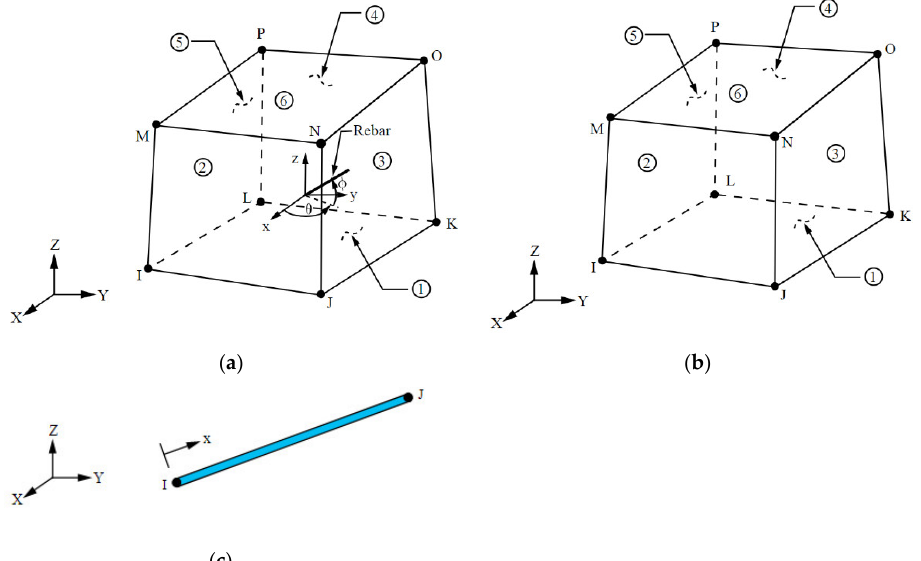
Figure 1. Types of Elements ( a ) SOLID65. ( b ) SOLID185. ( c ) LINK180.